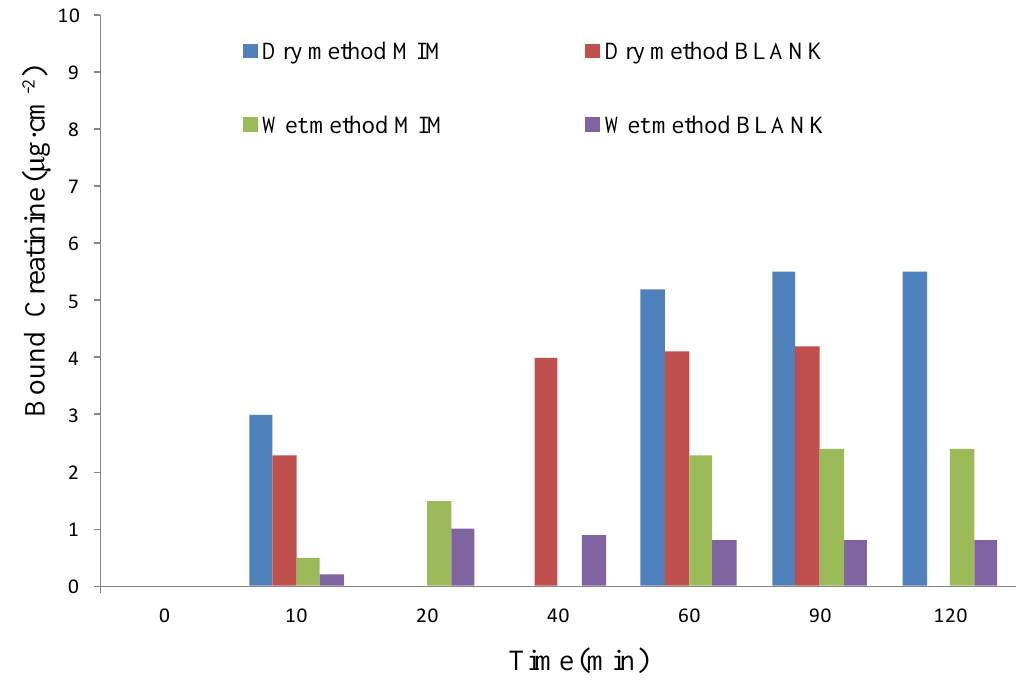
Figure 6. Rebinding of creatinine to MIM and BLANK membranes (Data from